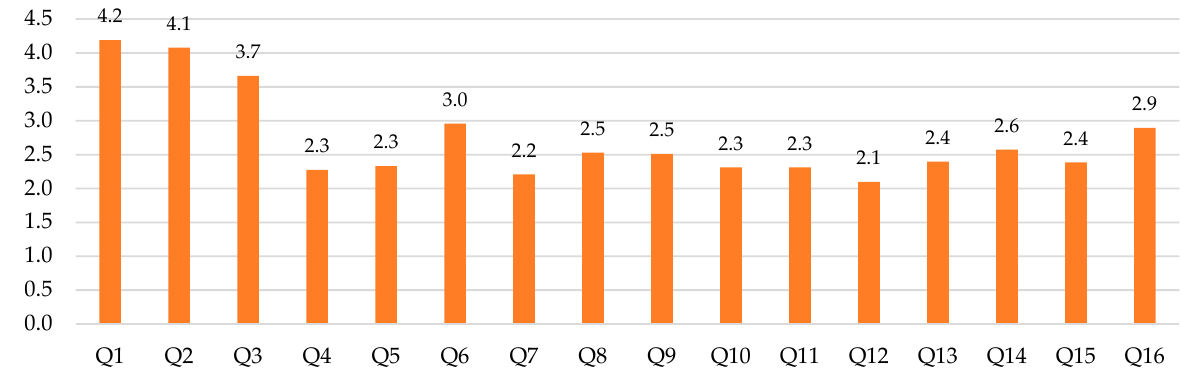
Figure 3. Percentage of video grades according to DISCERN, GQS, and JAMA . The mean DISCERN score was 35.6 (range 19.2–62), with a median of 33.8 (±9.2). The overall mean DISCERN score for each question (Q) was 2.73. For the GQS scale, the mean score was 2.4 (range 1–4), the median 2.4, and std 0.7. For JAMA, the mean score was 1.8 (range 1–4), the median 1.5, and std 0.7. The mean DISCERN scores for each Q are presented in Figure 4.